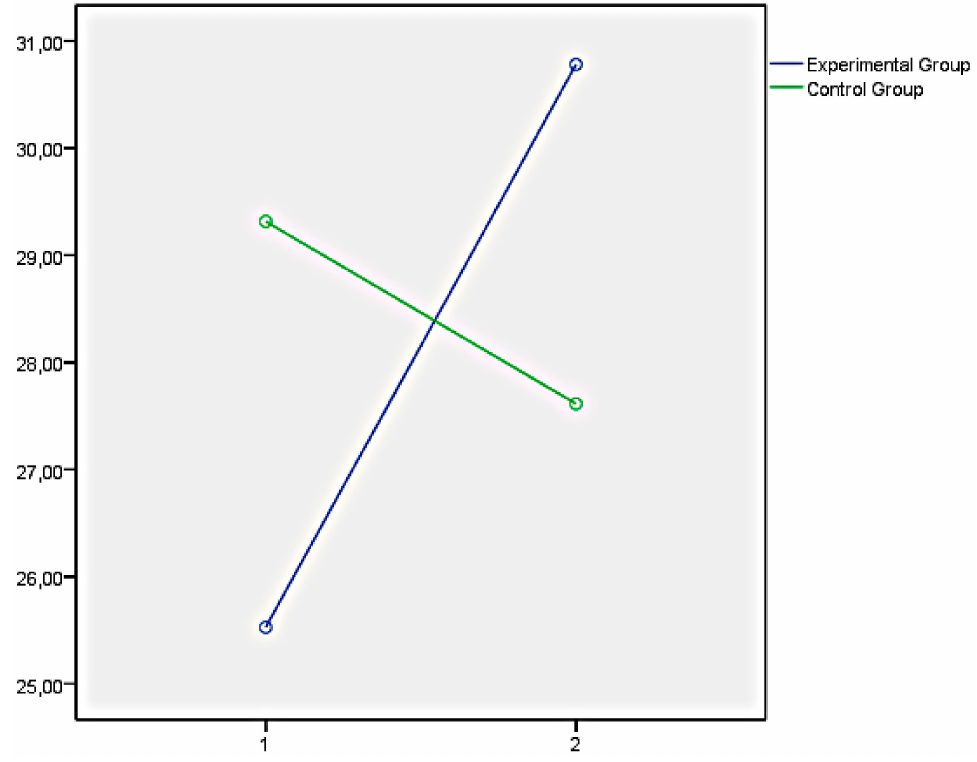
Figure 4. Repair after the educational intervention measured with Trait Meta-Mood